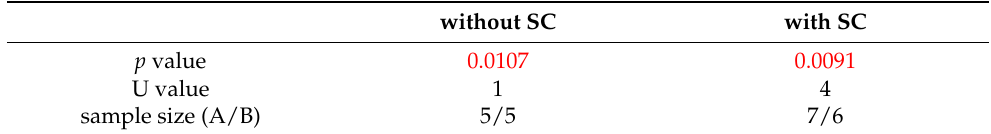
Table 4. Calculated p and u values (and the sample sizes) of interquartile ranges (Groups A and B). Significant differences are in red. without SC with SC p value 0.0107 0.0091 U value 1 4 sample size (A/B) 5/5